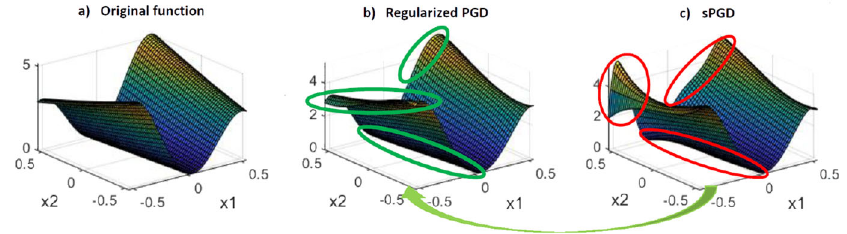
Fig. 3 Comparing the reference (Eq. (4.1)) and its associated s -PGD and rs -PGD regressions, at